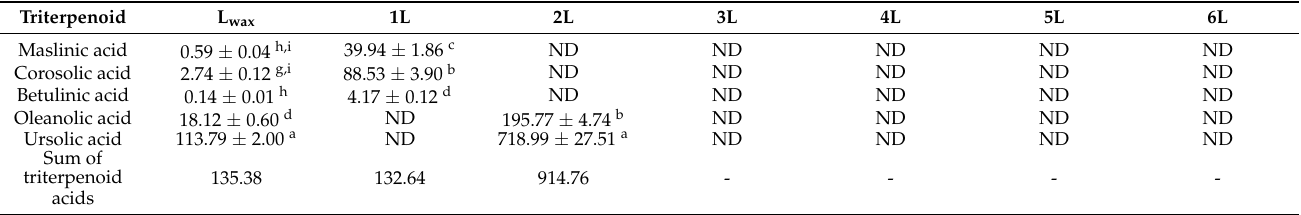
Figure 2. Representative HPLC-PDA chromatograms ( λ = 205 nm) of triterpenoid acids and neutral triterpenoids with chromophores in cuticular wax extracts of lingonberry fruits ( A ) and leaves ( B ). Peak assignments: 1—maslinic acid; 2—corosolic acid; 3—fernenol; 4—betulinic acid; 5—oleanolic acid; 6—ursolic acid; 7—betulin; 8—erythrodiol; 9—uvaol. Table 1. Content of triterpenoids (mg/g DW ± SD) in cuticular waxes (L wax ) and fractions (1–6L) of lingonberry leaves, determined by HPLC-PDA